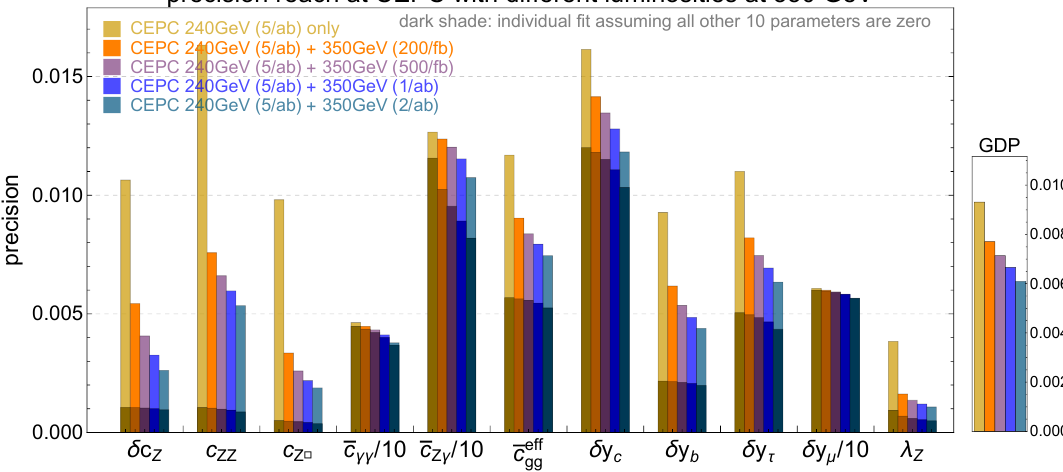
Figure 9 . Precision reach (one standard deviation) of the 11-parameter (cid:12)t in the Higgs basis at CEPC. Five di(cid:11)erent assumptions on the luminosity at 350 GeV are made, namely 0 (240 GeV run only), 200 fb (cid:0) 1 , 500 fb (cid:0) 1 , 1 ab (cid:0) 1 and 2 ab (cid:0) 1 (from left to right). The luminosity at 240 GeV is (cid:12)xed to 5 ab (cid:0) 1 . The parameters (cid:22) c (cid:13)(cid:13) , (cid:22) c Z(cid:13) and (cid:22) c e(cid:11) are de(cid:12)ned in eq. (2.2) and eq. (2.3) . The dark shades gg correspond to the constraints obtained when one single parameter is kept at the time, assuming all others vanish.